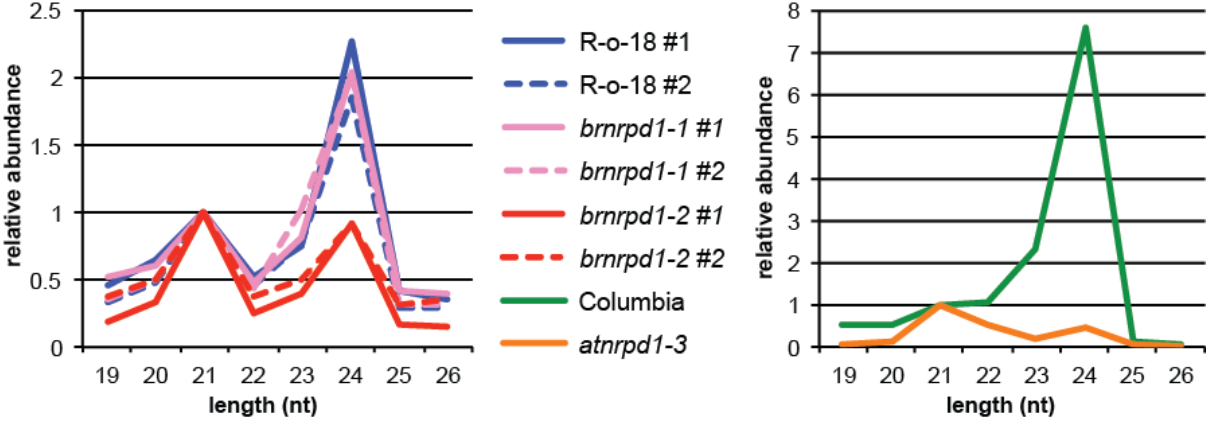
Figure 2. Size profile of small RNAs. Filtered, genome-matching sRNA reads from reproductive tissue of B. rapa ( left ) and Arabidopsis ( right ). R-o-18 and Columbia are wild type. Biological replicates are denoted #1 and #2.